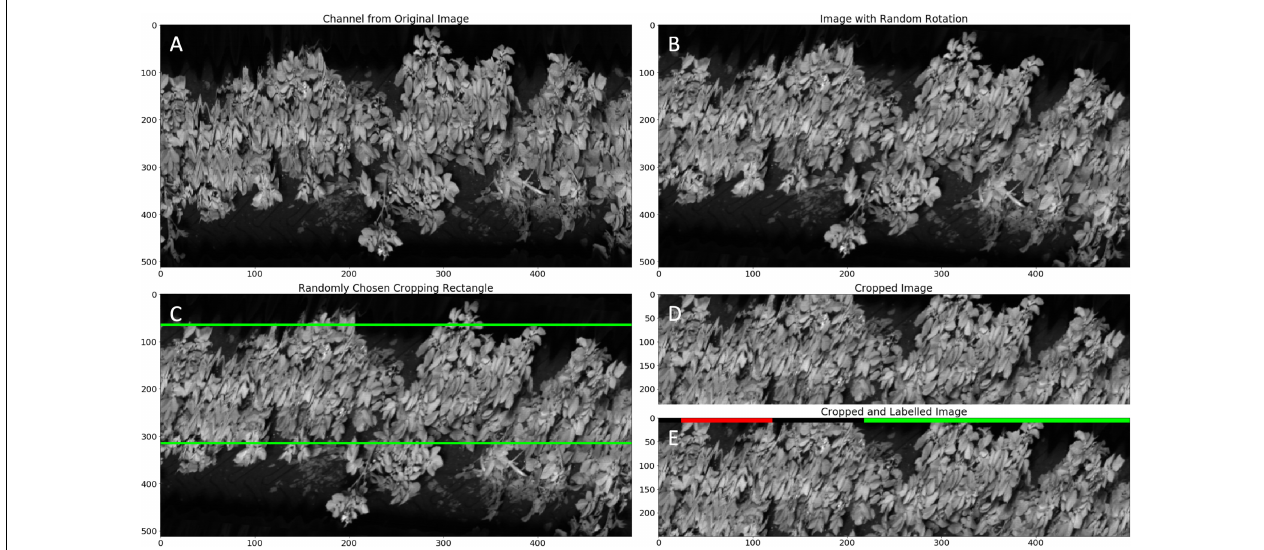
FIGURE 6 | Illustration of the procedure for generating a training image. The figure shows the 722 nm wavelength band. The original image is 500 × 512 (A) . This image is then rotated by a random angle uniformly distributed between –10 ◦ to 10 ◦ (B) . Subsequently a randomly positioned rectangle with dimensions 500 × 250 is cropped from the rotated image (C) to produce the training image (D) . The procedure for test images is the same, except there is no rotation step and the cropping rectangle is always vertically centered. Ground truth labeling is done on line bases (green – healthy, red – diseased, black – unknown) (E) .